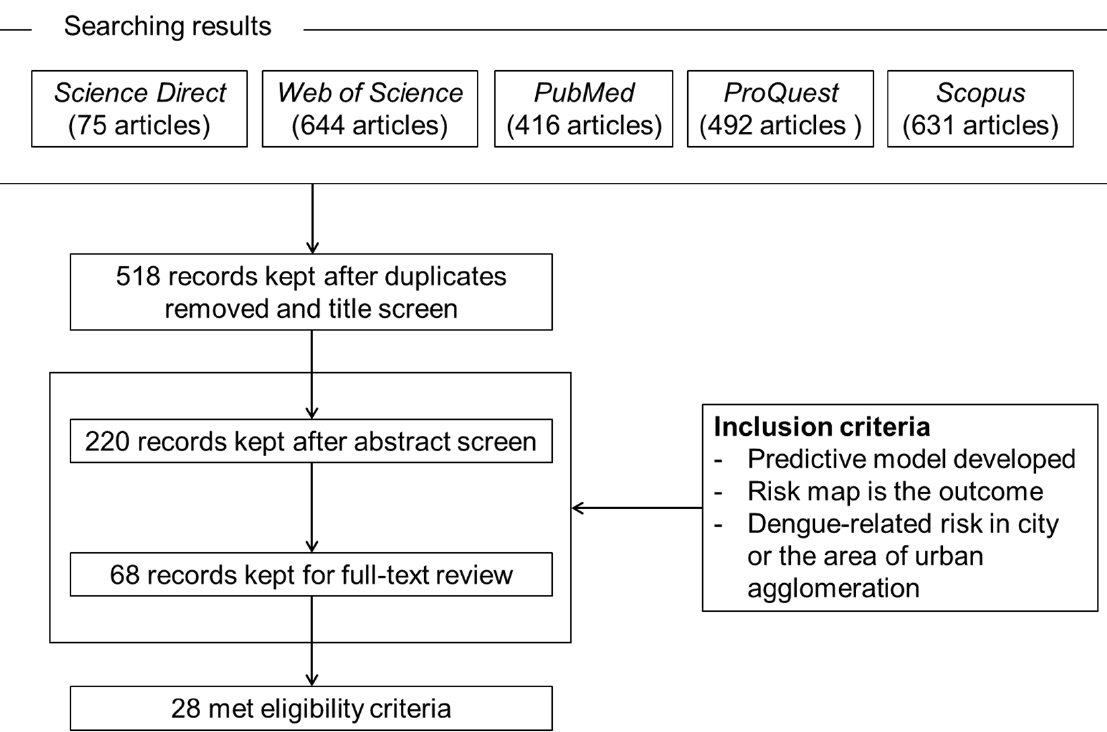
Figure 1. Flow diagram of article selection and inclusion process.